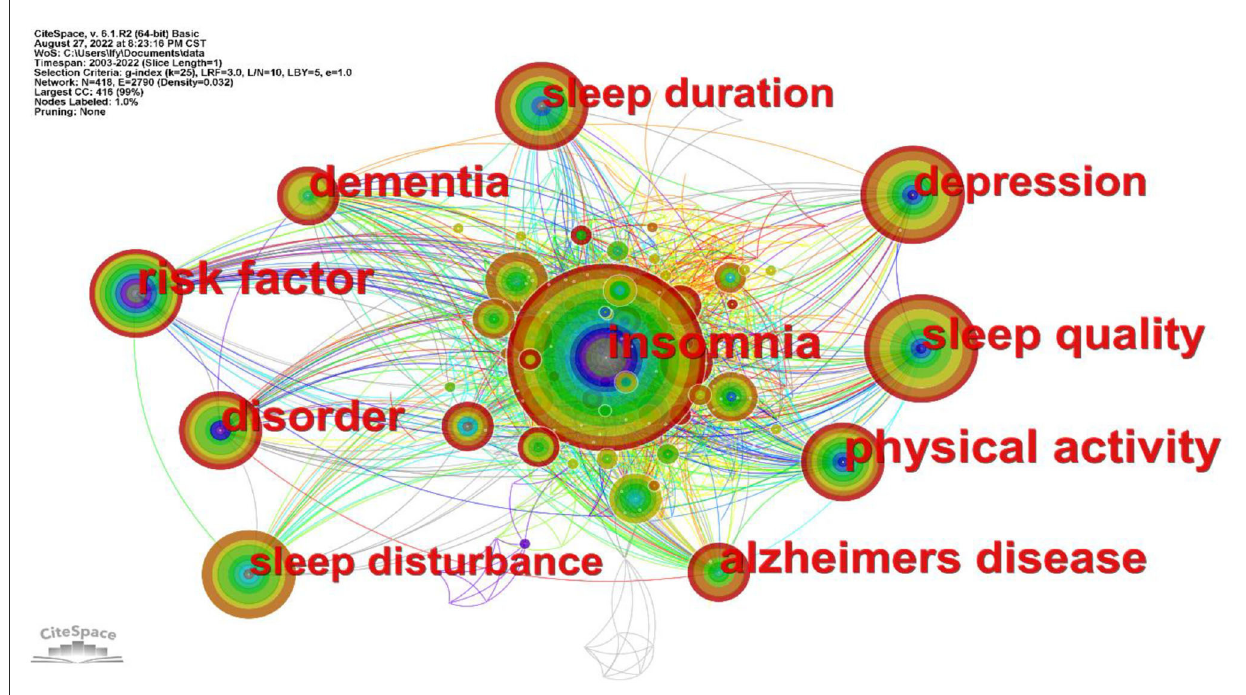
FIGURE6 Keyword co-occurrence knowledge map.